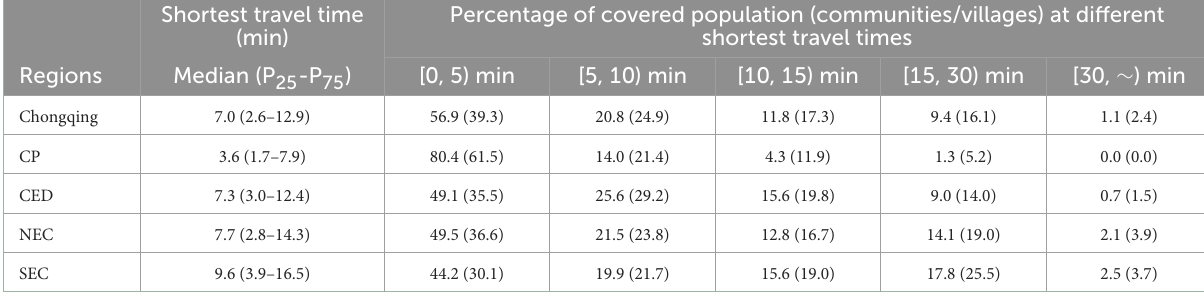
Percentage of covered population (communities/villages) at different